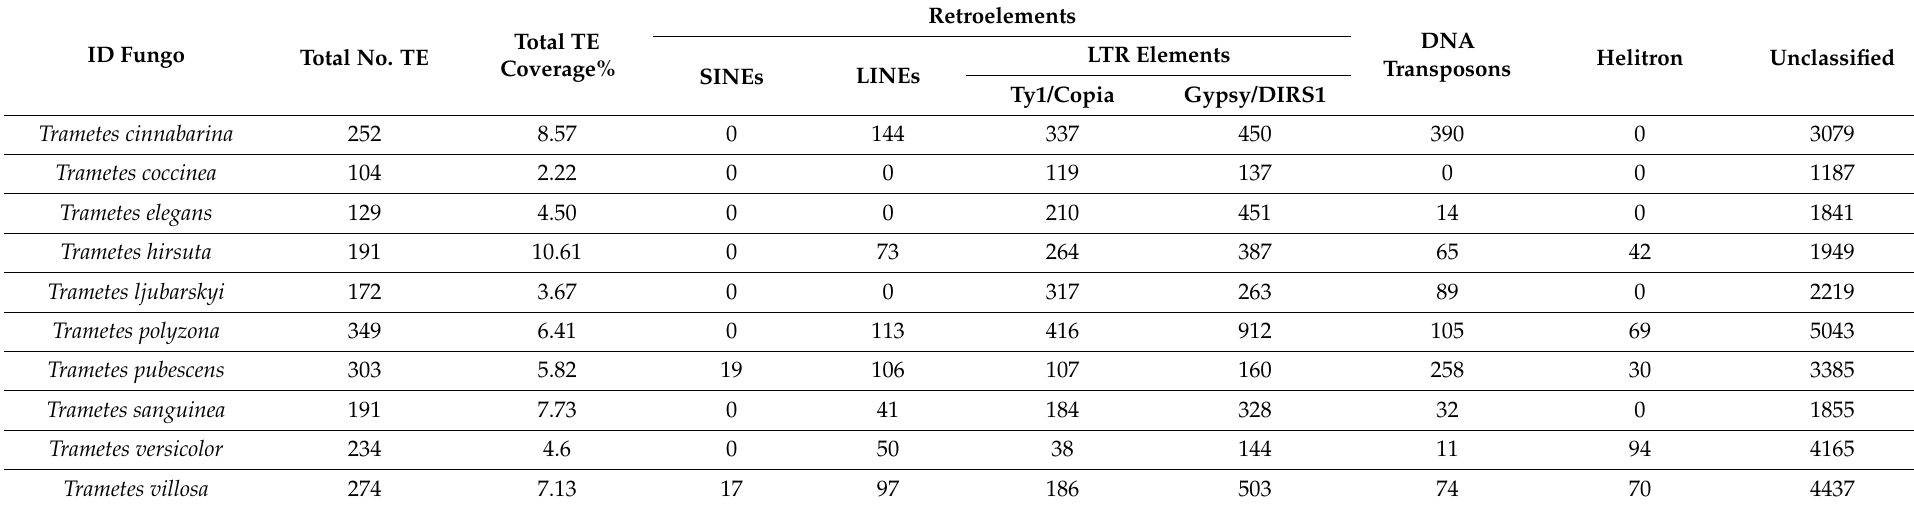
Table 4. Transposable elements (TE) identified in the Trametes